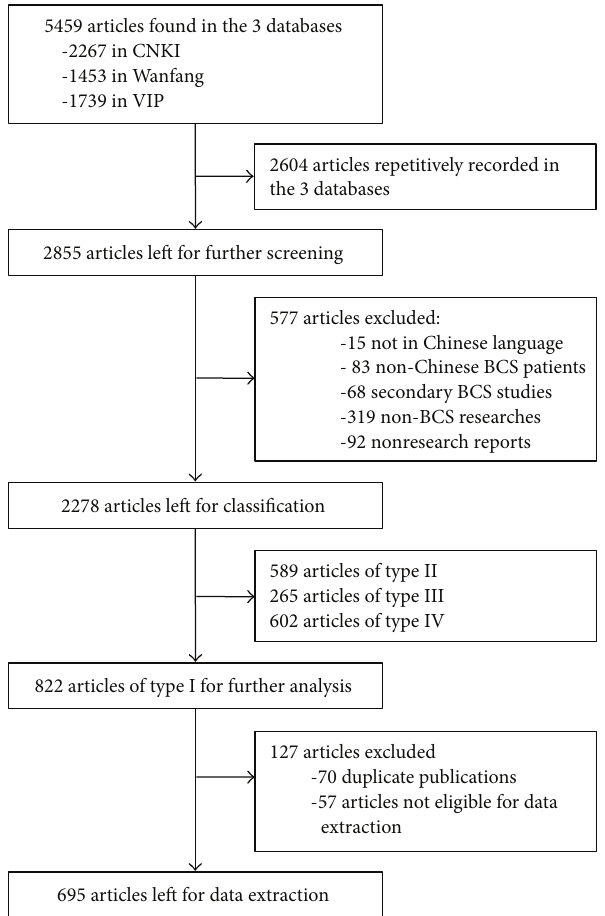
Figure 1: Flow chart for the literature management and